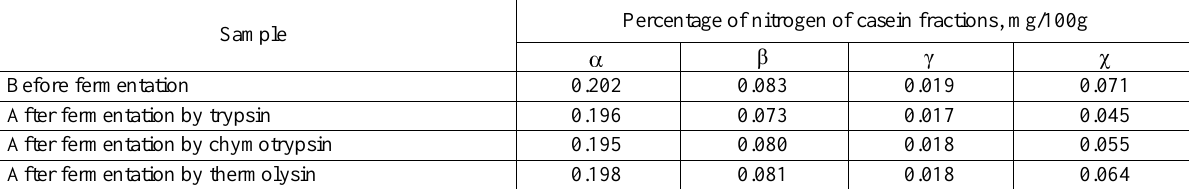
Table 6. Total content of albumins in hydrolyzates Sample